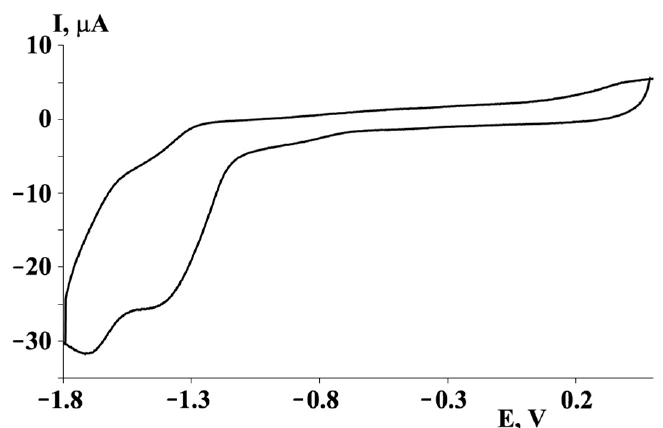
Figure 8. Cyclic voltammogram of 3 the potential switch from 0.50 to − 1.80 V (CH 2 Cl 2 , C = 2 mmol, 0.1 M TBAP, scan rate 200 mV ∙ s − 1 ).